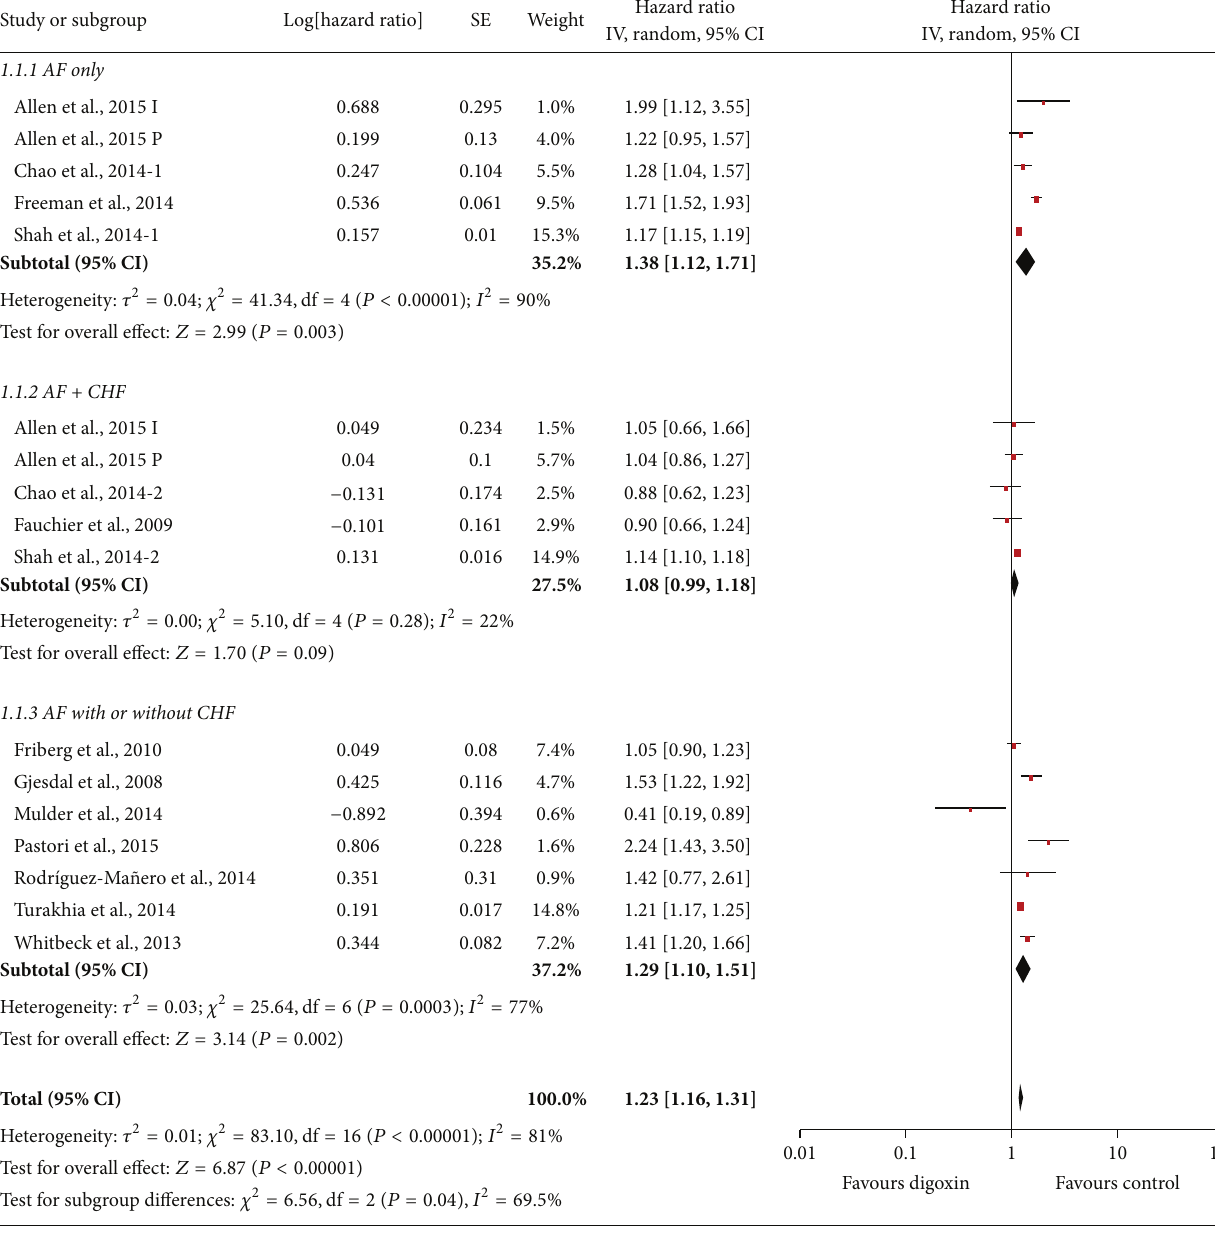
Figure 3: Forest plot showing combined effect of digoxin on all-cause mortality in studies with patients with atrial fibrillation only, atrial fibrillation with heart failure only, and atrial fibrillation with or without heart